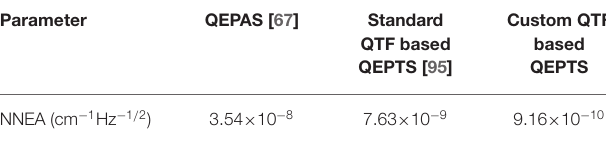
TABLE 1 | The measured performance of QTF based gas